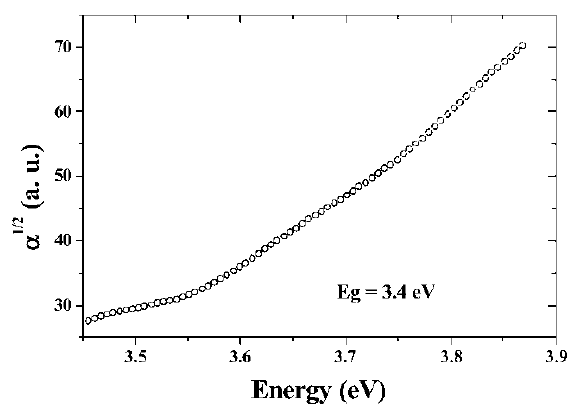
FIGURE 8 Square root of the absorption coefficient ( a 1 = 2 ) versus photon energy for nanocrystalline TiO 2 thin films deposited on a glass substrate (symbol) and a linear regression